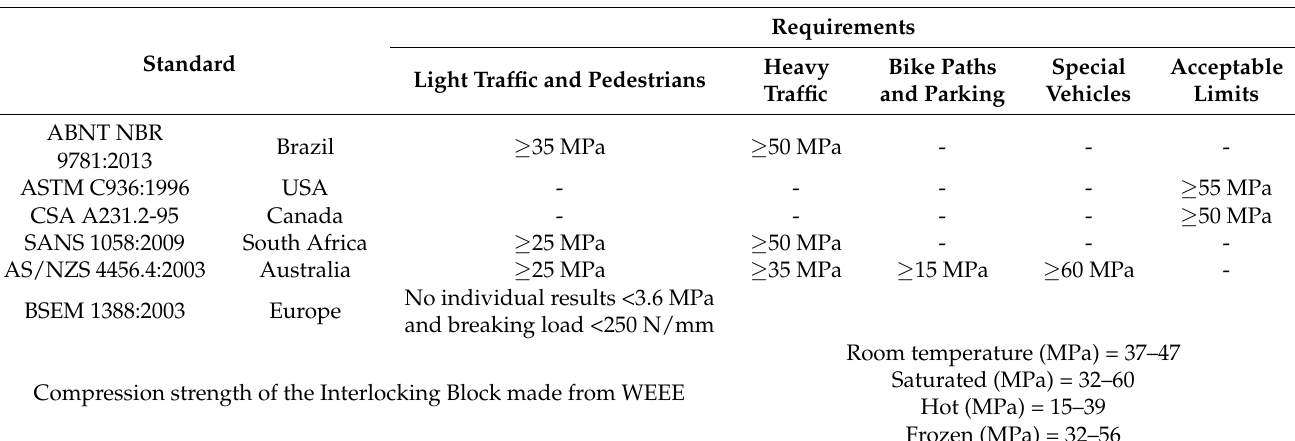
Figure 5. Stress x Strain graphs. The results for each test are presented for the four specimens obtained from each block (numbered as 3, 4, 5, 7, and 8, randomly selected as described above). Letters “a”, “b”, “c”, and “d” refers to the different essays. Table 2. Comparative table of resistance to compression